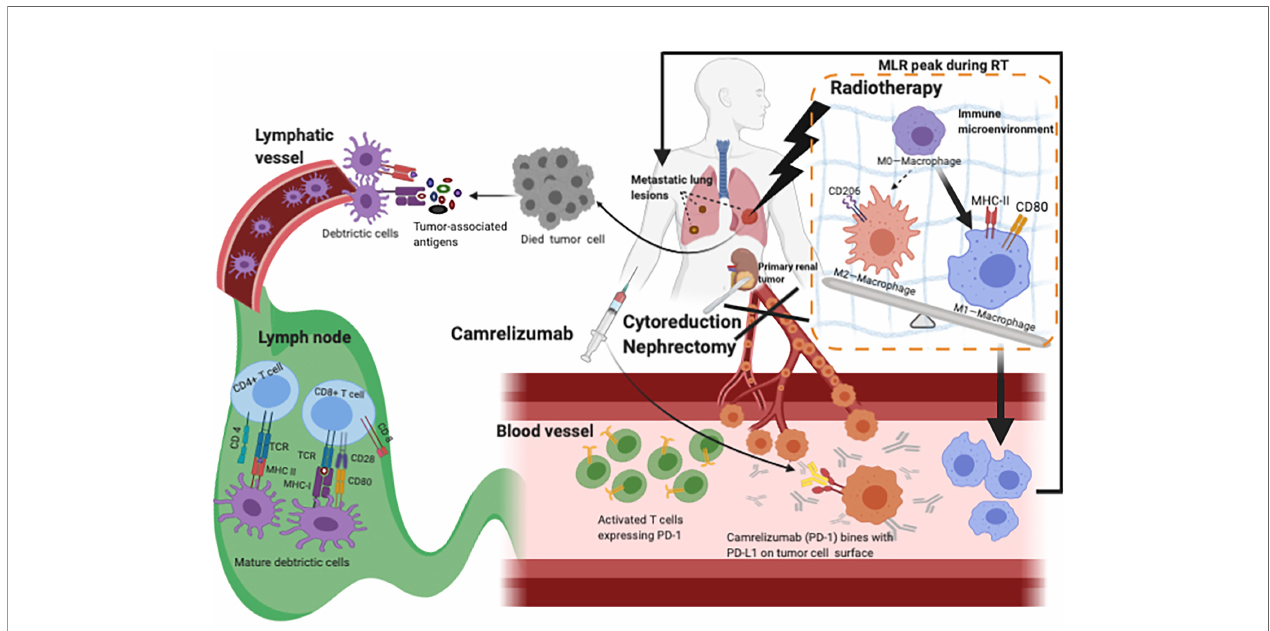
FIGURE 4 | Hypothesis for the mechanism of Camrelizumab combined with CN and RT. RT destroys tumor cells so that more tumor-associated antigens can be released and recognized by tissue-resident DCs, accelerating the activation of T cells which increases the rate of activated T cells. With CN decreasing the TB, enough Camrelizumab could combine with PD-L1 expressed on tumor cells, so that T cells avoid being suppressed and work. During Camrelizumab prescription, radiation may change the microenvironment which might convert more M0-macrophages into M1-macrophages. More activated T cells and M1-macrophages wandered in blood vessels, which can account for pseudoprogression and abscopal effect. CN, cytoreductive nephrectomy; RT, radiotherapy; DCs, dendritic cells; TB, tumor burden; PD-L1, programmed cell death receptor-ligand